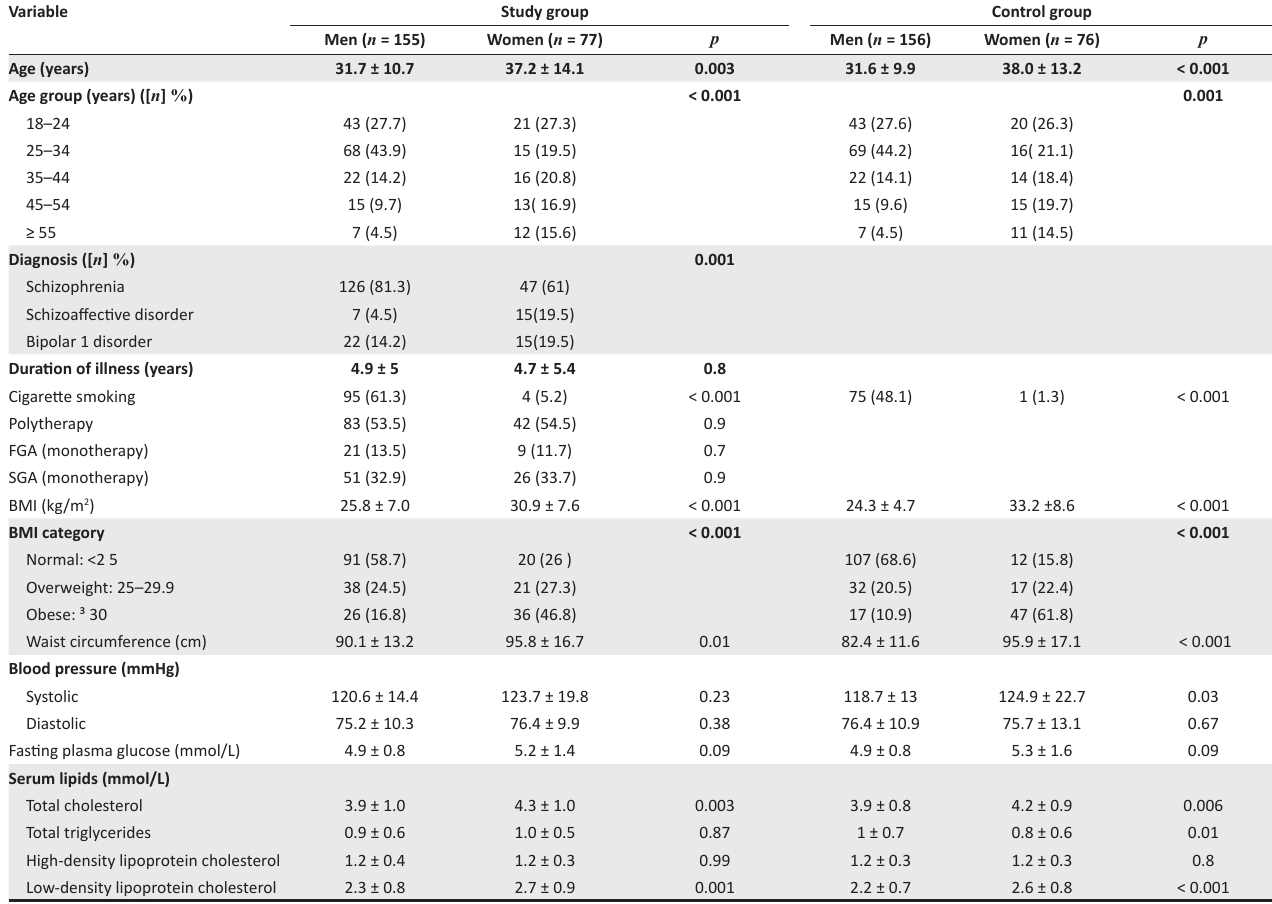
TABLE 1: Clinical and laboratory characteristics of the study group with severe mental illness and the control group.